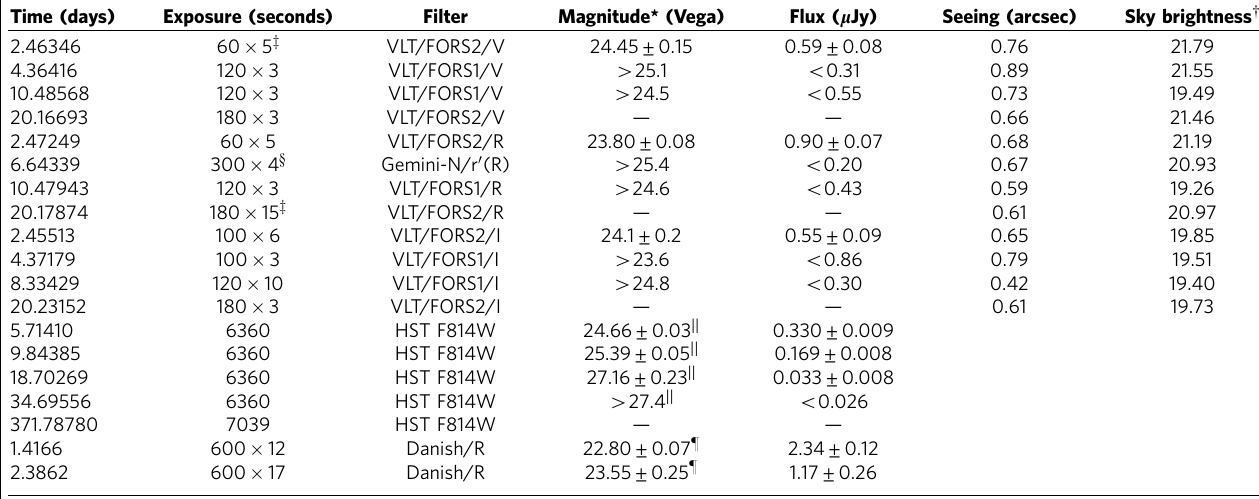
Table 2 | The optical observations of GRB